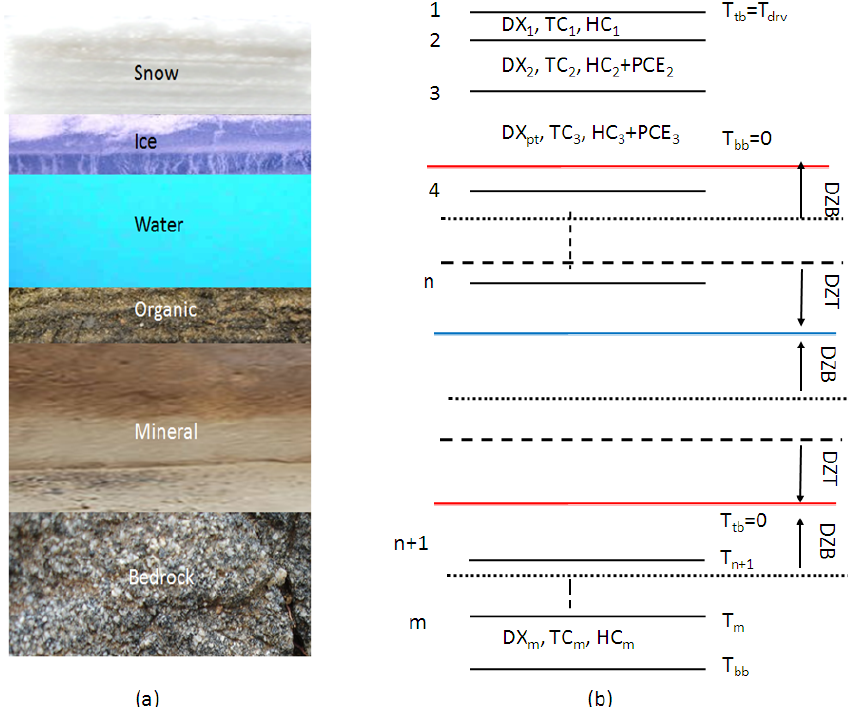
Figure A1. The ground components considered in the DOS-TEM (a) , and a diagram of updating freezing and thawing fronts of ground components, together with temperatures (b) . DX, TC, HC, and PCE stand for thickness, thermal conductivity, heat capacity, and energy used for phase change, respectively; there are altogether m layers: 1, 2, 3, n and m are layer indexes; DZT and DZB are the distances between the top-down and bottom-up driving depths (dashed and dotted horizontal lines) and the position of the front. Freezing and thawing fronts are indicated with blue and red solid lines, respectively. Vertical dashed lines indicate layers not shown. T tb , T bb , and T drv are the top boundary, bottom boundary and ground surface driving temperatures, respectively. The T bb at the bottom of the ground structure is determined by the temperature and thermal properties of the overlying layer and the prescribed heat flux.